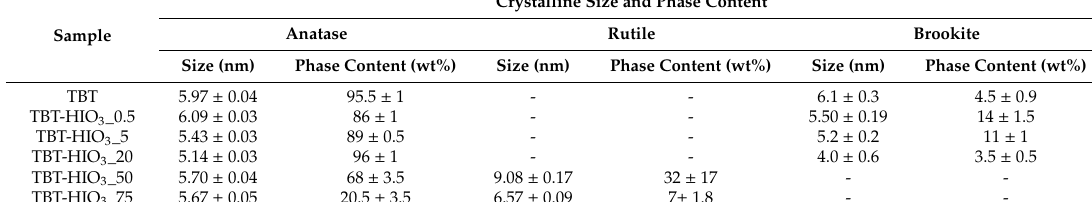
Figure 7. XRD patterns for defective TiO 2 -HIO 3 photocatalysts (A–anatase, B–brookite, and R– rutile). Table 5. Crystalline phases characteristic for the obtained defective TiO 2 -HIO 3 samples.